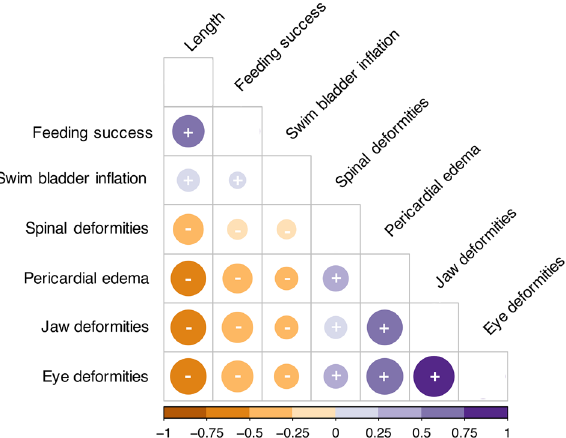
Figure 8. Correlation matrix calculated with the non-parametric Spearman method for biomorphometrics and deformity responses in individual exogenously feeding larvae from all treatments (n = 809 larvae, sampled at day 52 for 2.8 °C and day 76 for 0.5 °C). Dot size indicates strength of correlation coefficient with larger dots equating to higher correlation coefficients. Color and symbols indicate direction of the correlation with positive correlations in purple ( +) and negative correlations in orange (-). P-values are < 0.05 for all